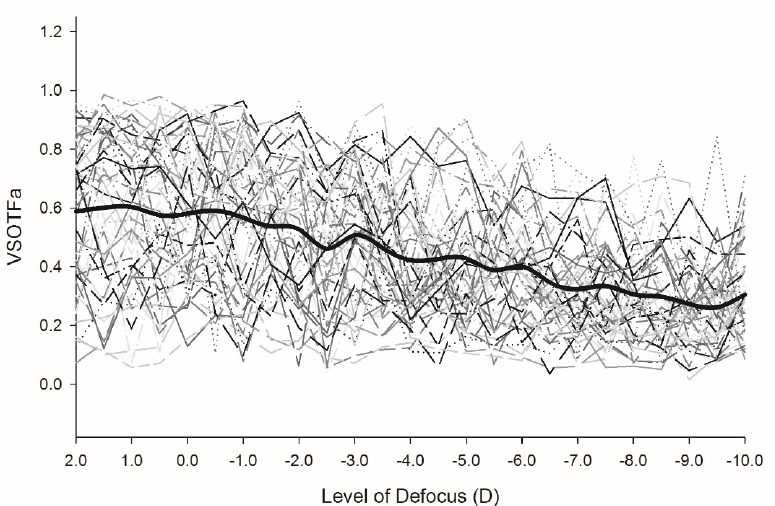
Figure 6. Objectively measured accommodative response converted to an image metric (VSOTFa) of each participant with the level of optical defocus. n = 50.